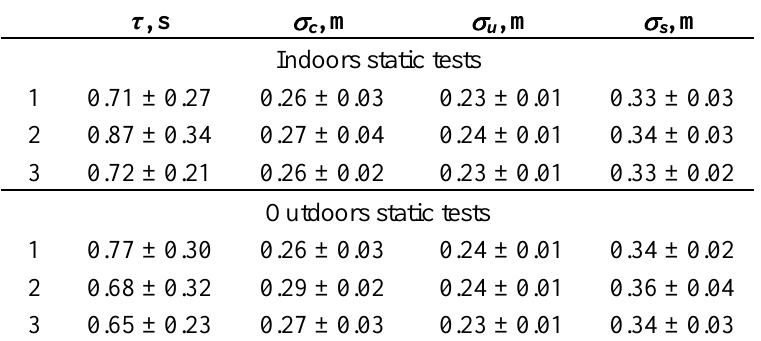
Table 1. ARMA model parameters (10% trimmed mean ± SD)—first day.